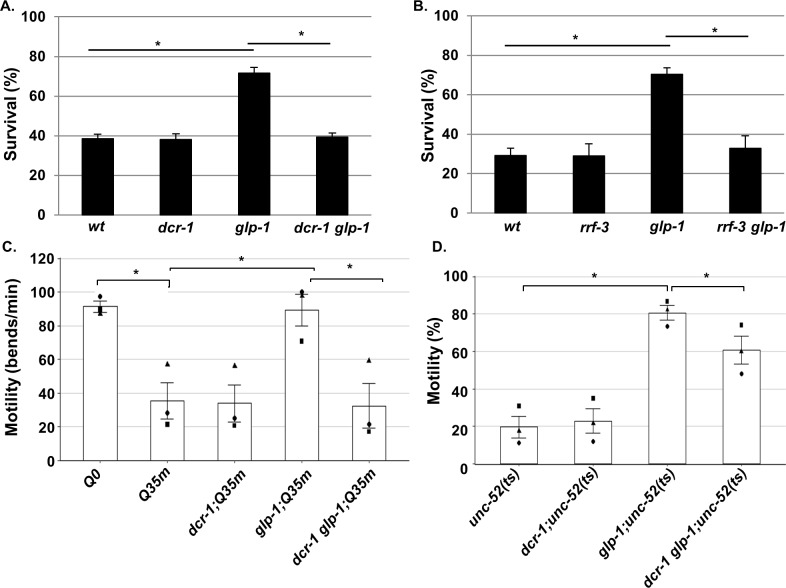
Endo-siRNAs are required for proteostasis maintenance in GSC(-) animals.(A–B) Thermo-resistance was examined in age-synchronized animals subjected to heat shock (37°C, 9 hr) on day 2 of adulthood. Survival was assayed after 5 hr of recovery at 25°C (120 animals per treatment, N = 3). Asterisks mark Cochran-Mantel-Haenszel Test values of p<0.001. (C) Bars represent mean of the percentage of motile animals scored in age-synchronized day 5 Q35m or glp-1;Q35m animals (more than 45 animals per treatment, N = 3). Different shapes represent mean motility in independent experiments. Asterisks mark p-values<0.001 determined by One-Way ANOVA followed by Tukey's post hoc analysis. (D) Bars represent mean of means of the number of body bends per minute in age-synchronized day four unc-52(ts) animals. Animals were raised at 25°C till day 1 of adulthood, and shifted to the permissive temperature (15°C) thereafter. A total of 180 animals per strain were scored in three independent experiments. Different shapes represent mean motility in independent experiments. Asterisks mark Cochran-Mantel-Haenszel test values of p<0.001. Data are presented as mean ± SEM. See Supplementary file 8 for statistic details.